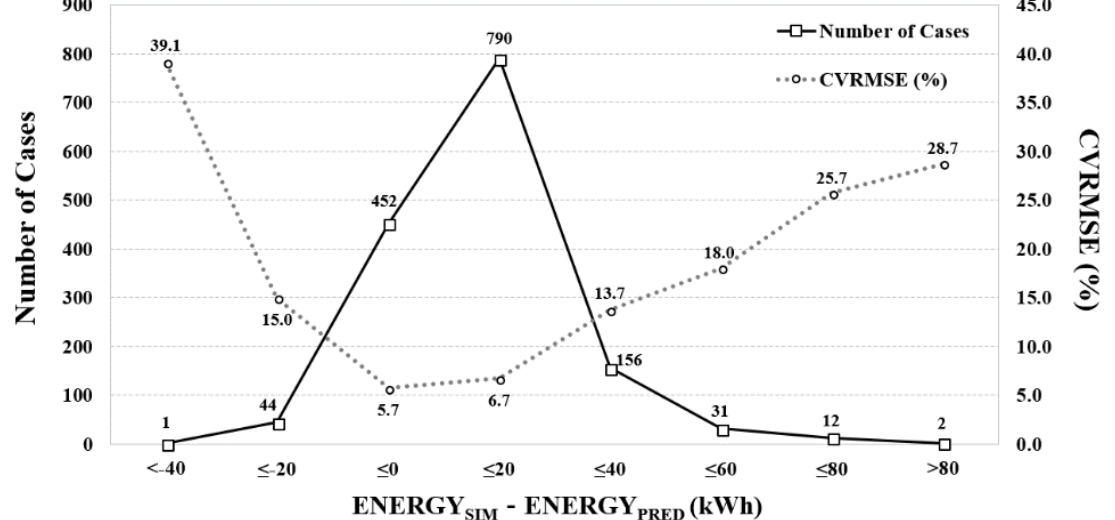
Figure 12. Number of cases and CVRMSE (%) for difference between simulated energy consumption and predicted energy consumption.